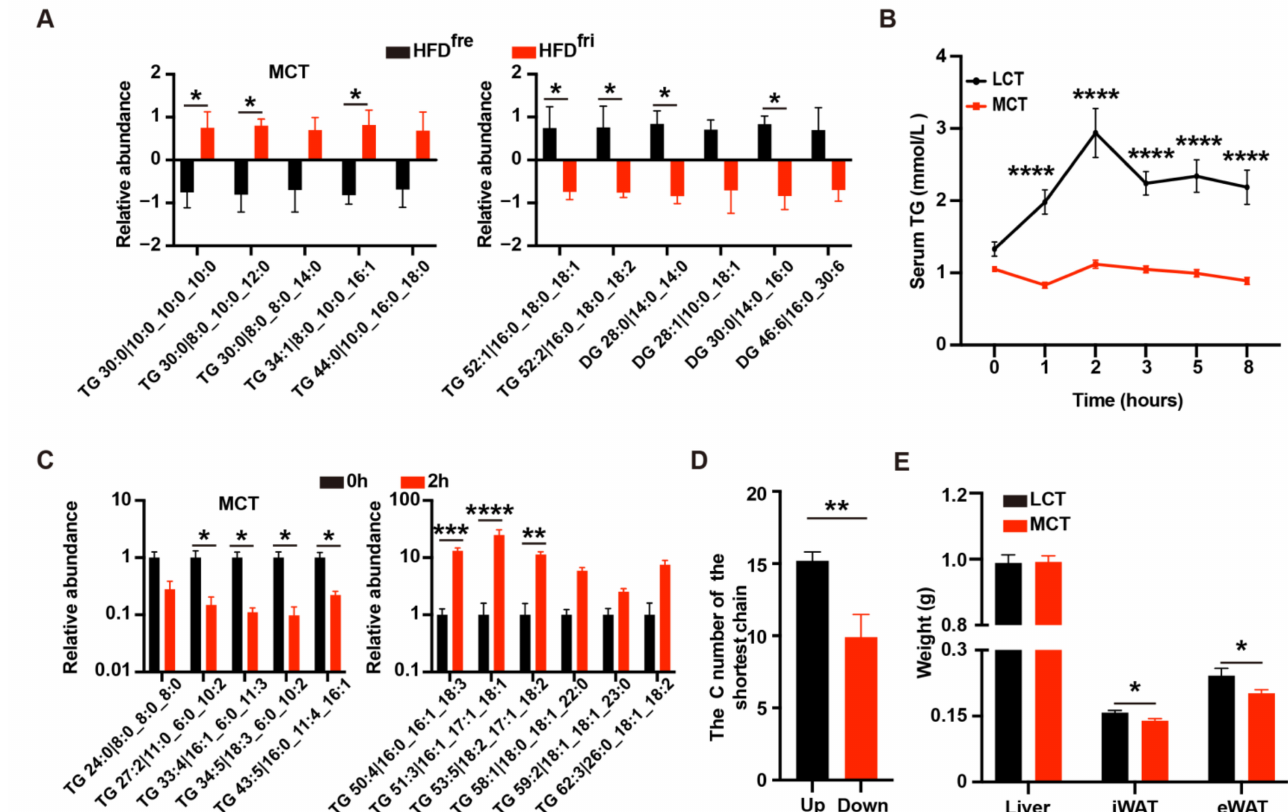
Figure 2. Medium-chain triglycerides (MCT) induced phenotypic changes in the mice fed by high-fat diets (HFD) stored in the fridge (fri) (HFD fri ). ( A ) Lipidomics analysis of the diet revealed increases of medium-chain triglycerides (MCT) (left panel, p < 0.0001 from two-way ANOVA) and decreases of long-chain triglyceride (LCT)/long-chain diglyceride (LCD) (right panel, p < 0.0001 from two-way ANOVA) in high-fat diets (HFD) stored in the fridge (fri) (HFD fri ) (n = 3 for each group); ( B ) the oral lipid tolerance test (OLTT) with MCT-enriched oil or sunflower oil in wild-type mice without exposure to HFDs ( p < 0.0001 from two-way ANOVA) (n = 10 for each group); ( C ) relative abundance of MCT (left panel, p < 0.0001 from two-way ANOVA) and LCT (right panel, p < 0.0001 from two-way ANOVA) in the serum of mice in the initial or two-hour time point of OLTT (n = 3 for each group); ( D ) the average length of shortest chain for triglycerides (TG) with high (up, n = 48) or low (down, n = 10) absorptive efficiency; ( E ) the weight of the liver, inguinal white adipose tissue (iWAT), and epididymal white adipose tissue (eWAT) in the 8-week-old male mice fed by MCT-enriched oil or sunflower oil for three weeks (n = 9 for each group). The adjusted p -values from multiple comparison tests are indicated as *, p < 0.05; **, p < 0.01; ***, p < 0.001; ****, p < 0.0001. The results of the Student t -test are provided in Supplementary Table